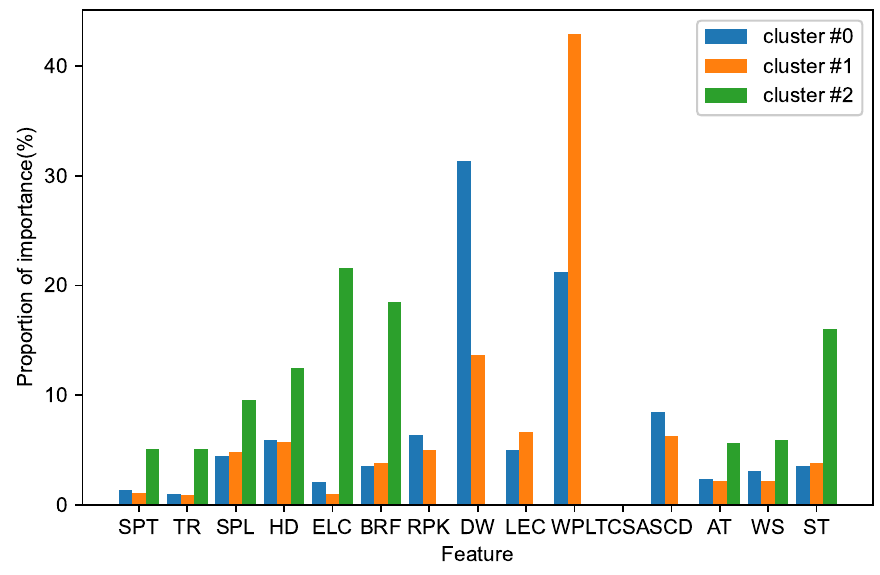
Figure 8. The proportion of feature importance to the sag difference in the